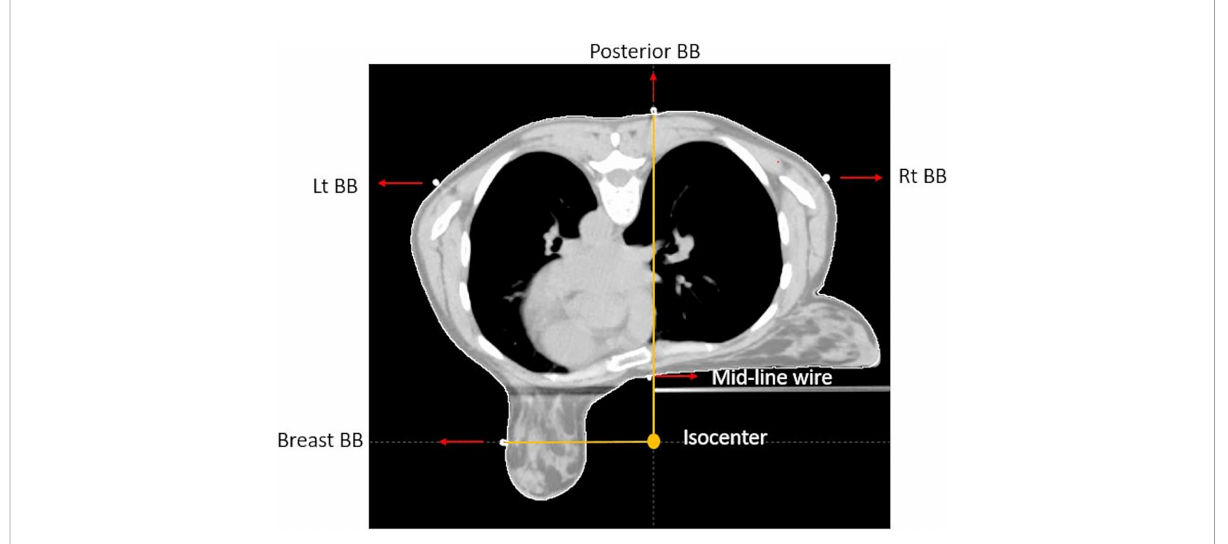
FIGURE 1 CT axial view of prone breast, showing isocenter location, triangulation point, lateral aspect of the breast marker, and midline marker.